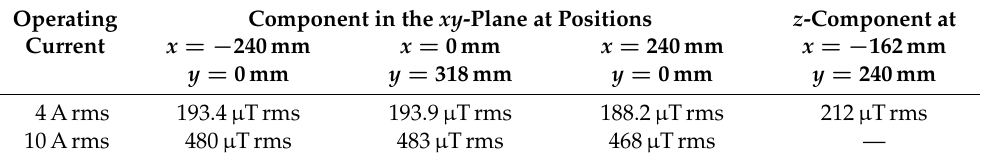
Table 2. Maximum values of the magnetic flux density of the charging system.